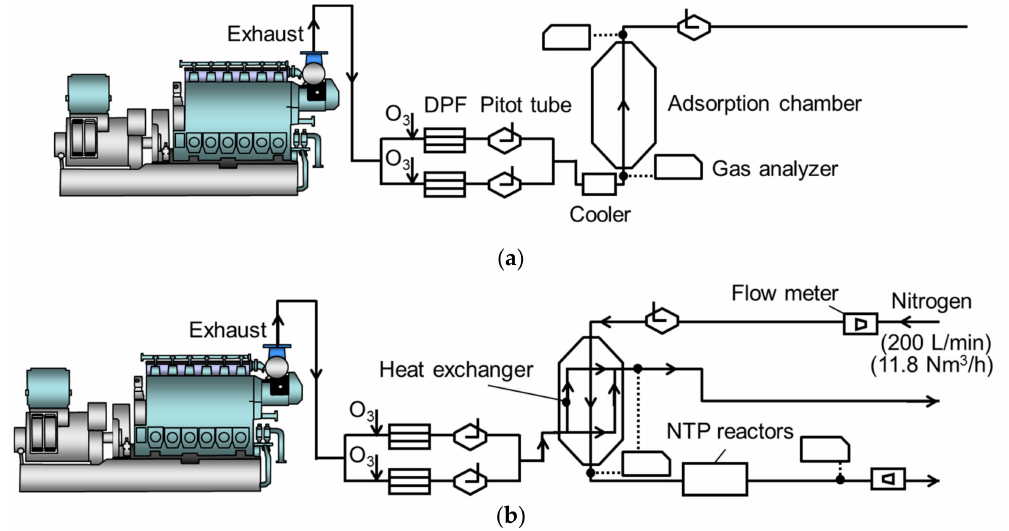
Figure 1. Process diagram of the NO x reduction system for a marine diesel engine: ( a ) adsorption process; ( b ) desorption